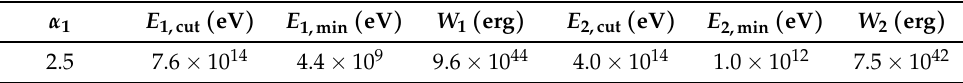
Figure 4. The two-component leptonic scenario for the head region. The dark green solid and dashed lines are the synchrotron and IC radiation of the power-law type electrons, respectively, and the red dash–dotted and dotted lines are the synchrotron and IC radiation of the Maxwellian-type electrons, respectively. The gold dash–dot–dotted curve and the blue dashed curve show the 1 Ms sensitivity of the next-generation MeV gamma-ray detectors e-ASTROGAM [50] and AMEGO [51], respectively. Observation data are the same as the ones in Figure 3. Table 5. Fitting parameters of the two-component leptonic scenario with a relatively weaker magnetic field, corresponding to Figure